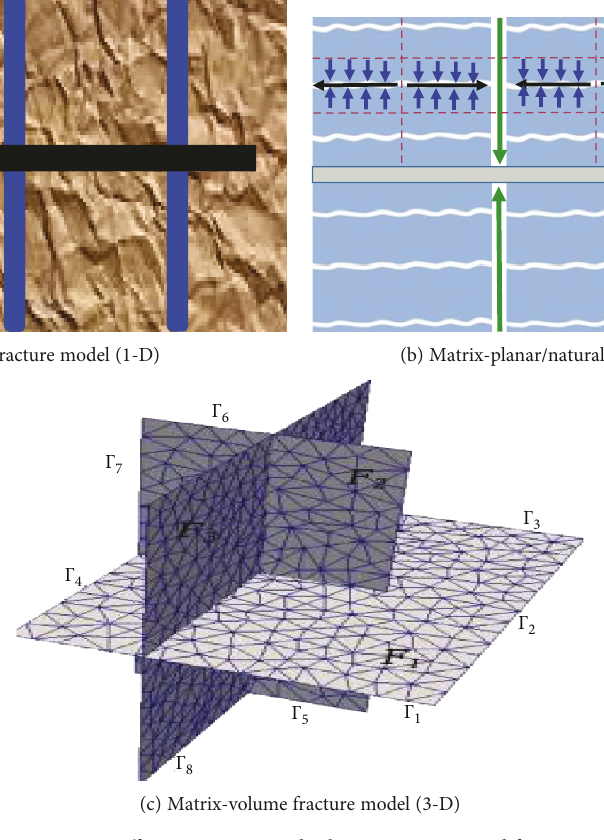
Figure 3: Di ff erent contact modes between matrix and fracture.